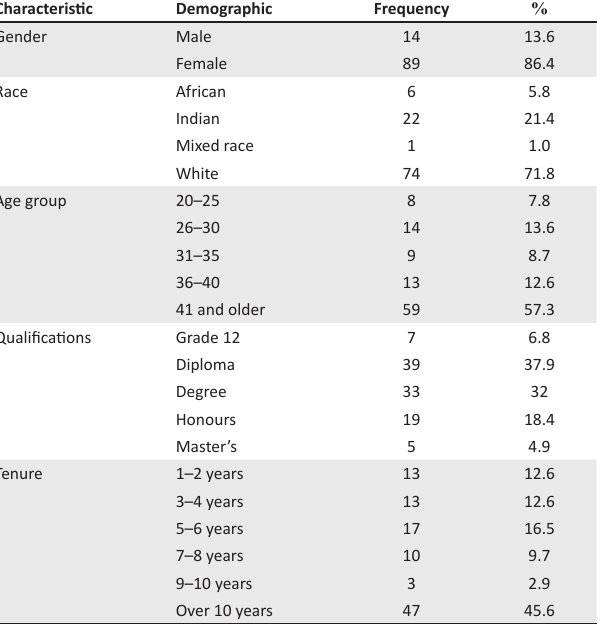
TABLE 1: Demographic characteristics of participants. Characteristic